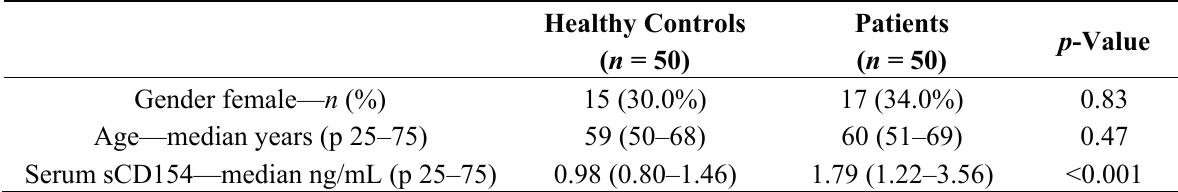
Table 1. Characteristics of healthy controls and patients with severe MMCAI.